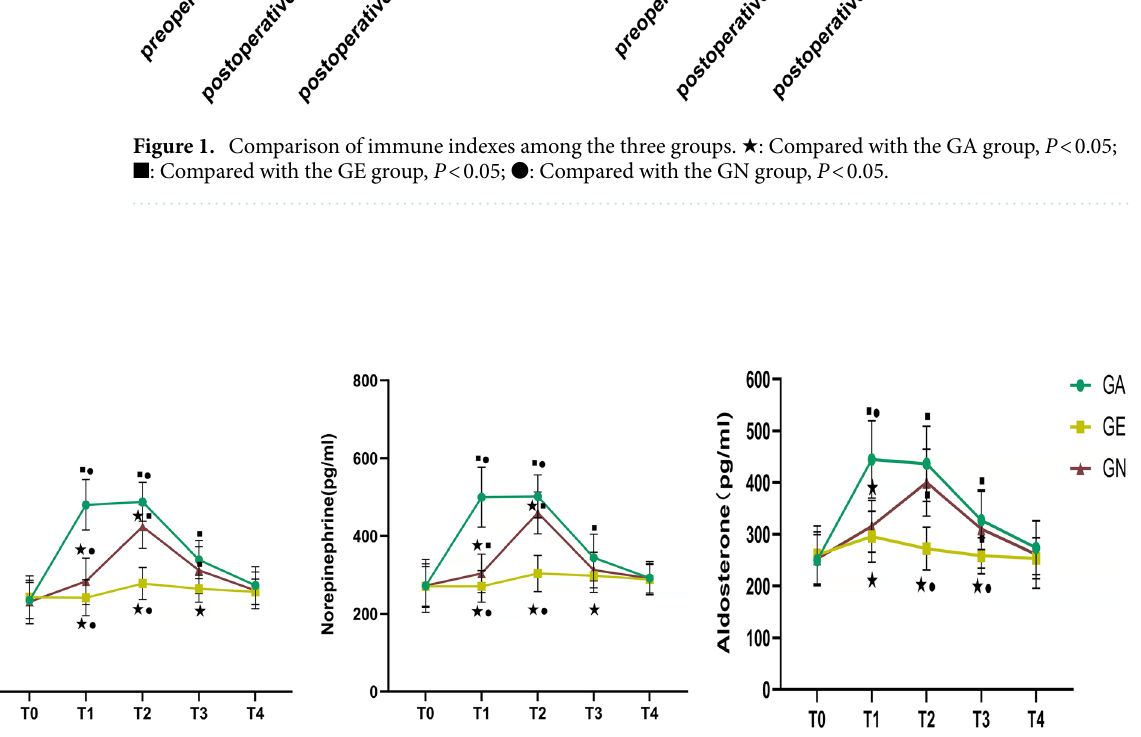
Figure 2. Comparison of stress indexes among the three groups. ★ : Compared with the GA group, P < 0.05; ■ : Compared with the GE group, P < 0.05; ● : Compared with the GN group, P <